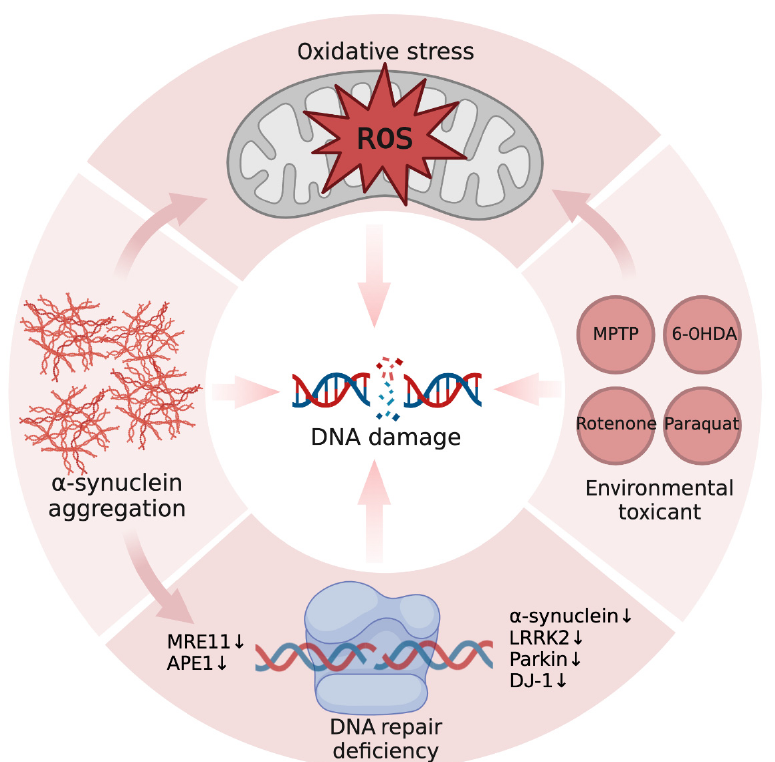
Figure 1. Sources of DNA damage in PD. Reactive oxygen species (ROS) can directly attack genomic DNA, causing many types of DNA damage. Pathogenic α -synuclein can damage DNA indirectly through ROS or directly cleave DNA, leading to DNA strand breakage. On the other hand, α -synuclein can also cause DNA repair defects by affecting the expression of DNA repair proteins, including MRE11 and APE1. Recent studies have highlighted the role of PD-causing proteins in DNA repair, including endogenous α -synuclein, LRRK2, parkin, and DJ-1, which partially explains the cause of abnormal DNA repair and damage accumulation in PD. Finally, environmental toxicants, an important component in the pathogenesis of sporadic PD, can also induce genomic DNA damage and lead to DNA damage-dependent dopaminergic neuron death. The pink arrows in the figure represent causal effects, and the black arrows indicate downregulation of protein expression. (Created with BioRender.com).